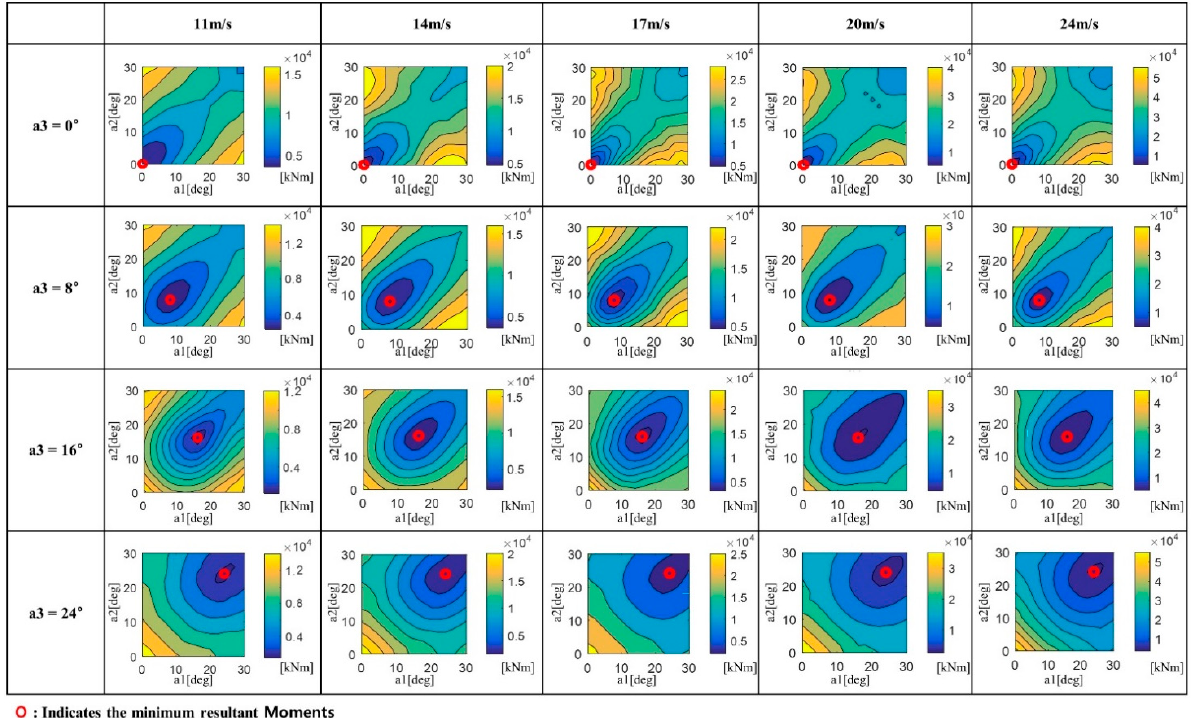
Figure 5. Aerodynamic imbalance loads of M R_ipa .